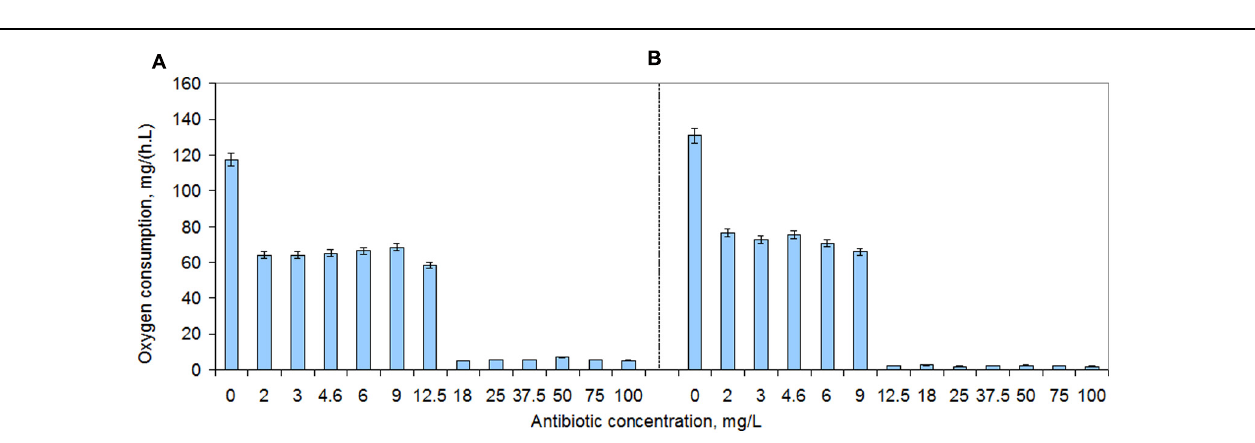
FIGURE 7 | Oxygen consumption rates of S. aureus cells during 2–100 mg/L vancomycin (A) and teicoplanin (B) exposure. The plates were incubated at 37 ◦ C and 200 rpm. Error bars represent standard deviation